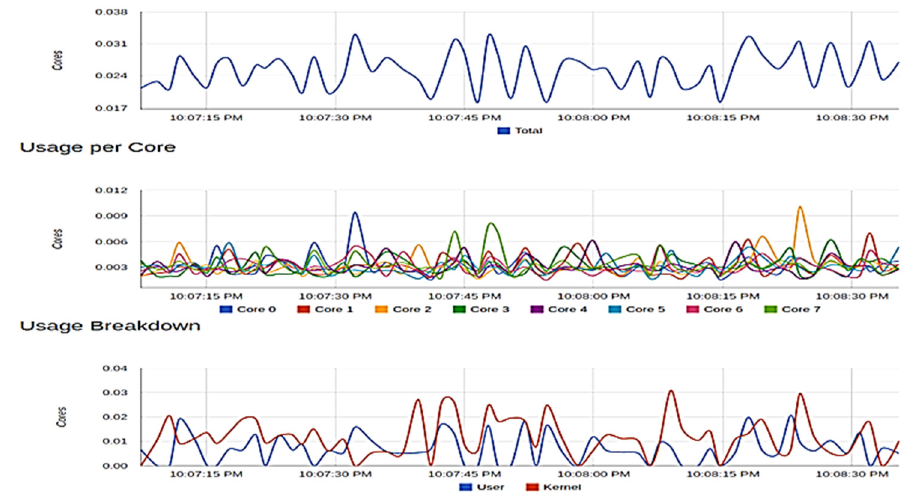
Figure 11. Resource usage of edgex-core-metadata.